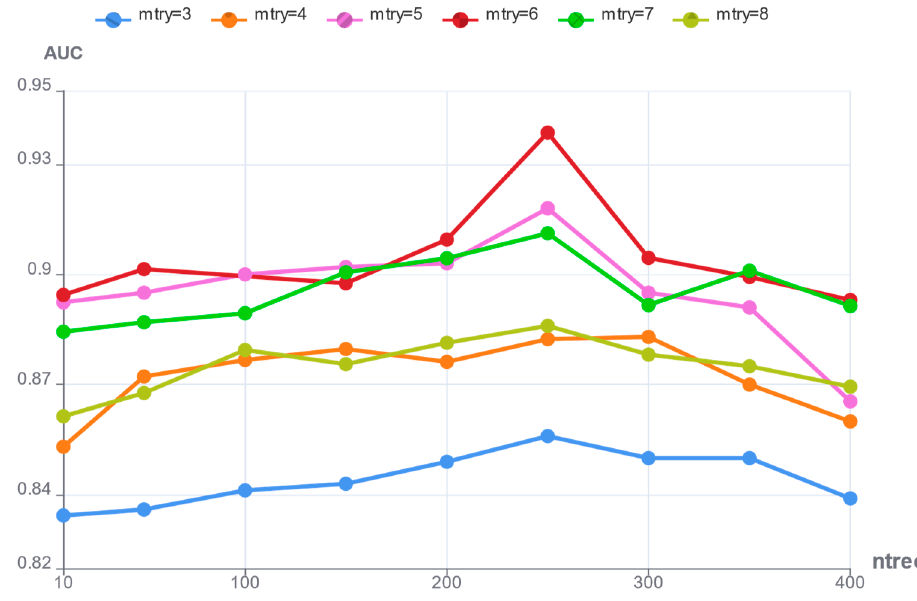
Figure 7. The graph of the correct rate of judgment with increasing reports.